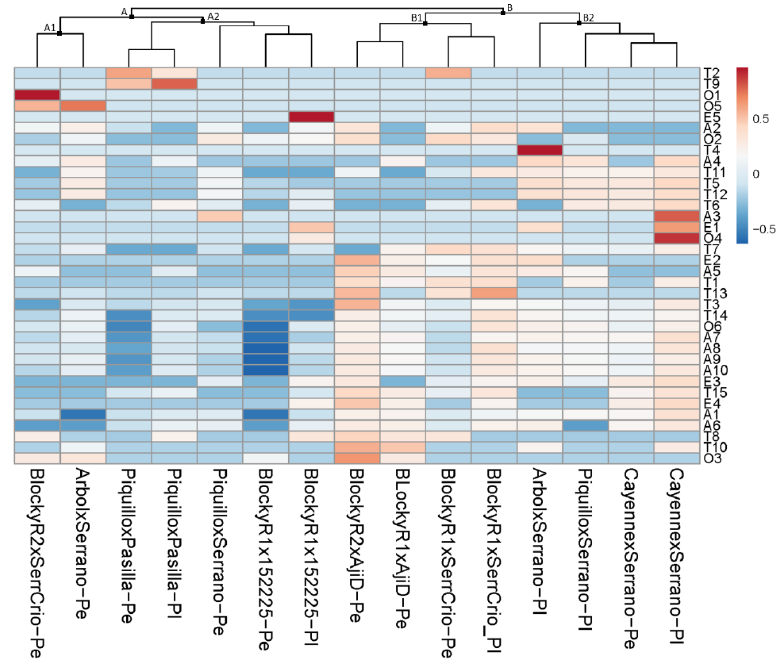
Figure 2. Heatmap hierarchical cluster analysis of the volatiles identified in the hybrid accessions studied, corresponding to the pericarp (Pe) and placental (Pl) tissues. Accession and volatile abbreviations correspond to those indicated in Tables 1 and 2, respectively.